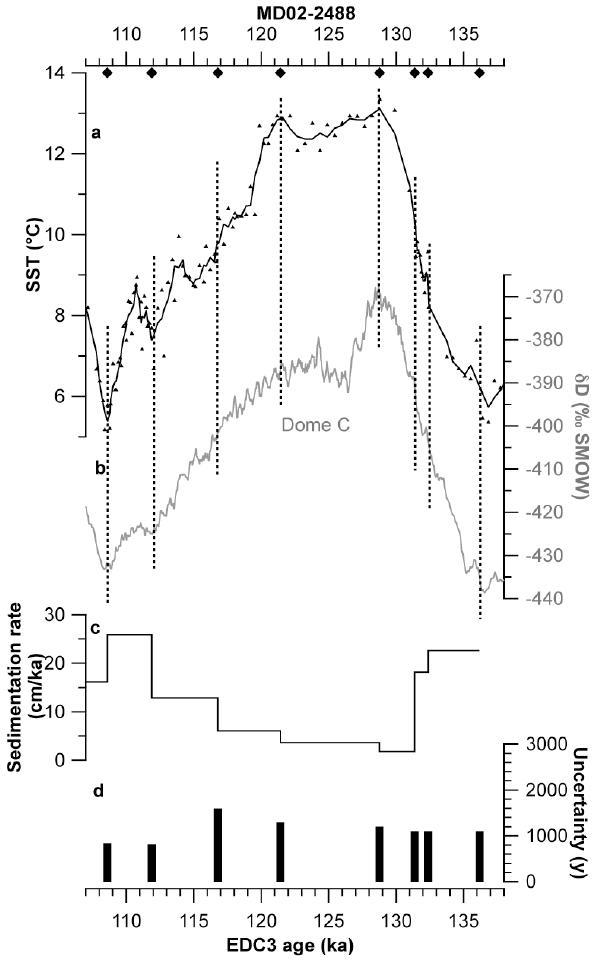
Figure 4: Definition of the age model of core MD02-2488 from the Southern Ocean. (a) Sea 2 Fig. 4. Definition of the age model of core MD02-2488 from the Surface Temperature (3-point smoothing curve, black line) from core MD02-2488 (Govin et 3 Southern Ocean. (a) Sea surface temperature (3-point smoothing curve, black line) from core MD02-2488 (Govin et al., 2009). Dia- al., 2009). Diamonds and vertical dotted lines highlight the tie-points. (b) Antarctic EDC ! D 4 monds and vertical dotted lines highlight the tie-points. (b) Antarc- record (EPICA Community members, 2004; Jouzel et al., 2007) (5-point smoothing curve, 5 tic EDC δ D record (EPICA Community members, 2004; Jouzel et grey line). (c) Sedimentation rate variations in core MD02-2488. (d) Age uncertainty of the 6 al., 2007) (5-point smoothing curve, grey line). (c) Sedimentation tie-points defined between core MD02-2488 and EDC ice core (see Table 4 for details). 7 rate variations in core MD02-2488. (d) Age uncertainty of the tie- points defined between core MD02-2488 and EDC ice core (see Table 4 for